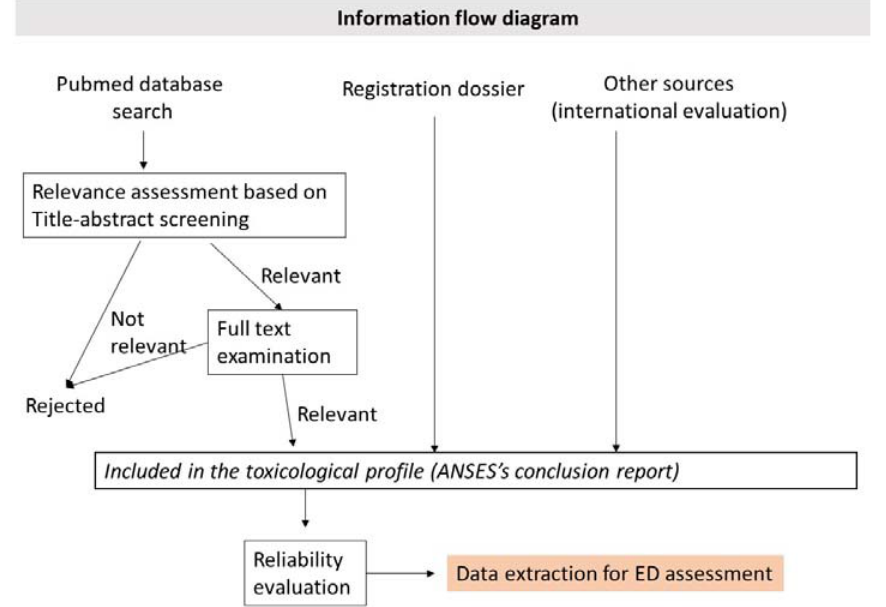
Figure 1. Information flow diagram.